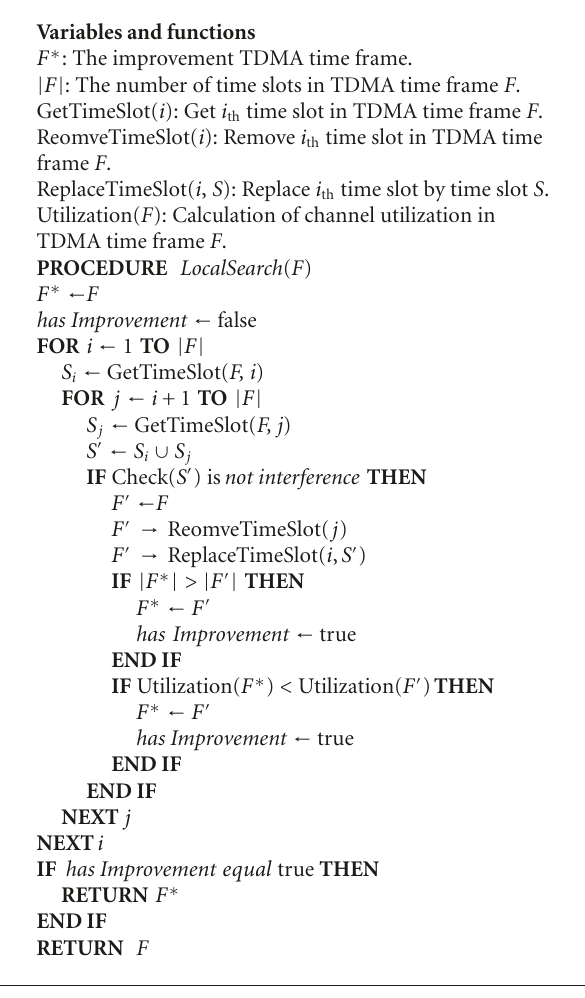
Algorithm 4: Pseudocode of our local search operator.